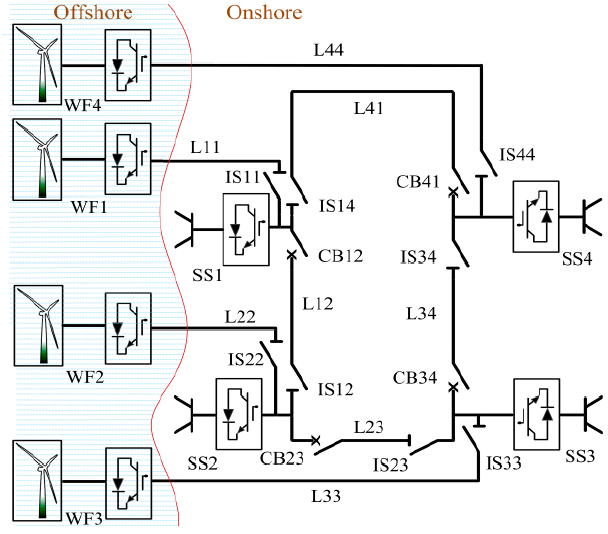
Figure 4. SSRT topology.